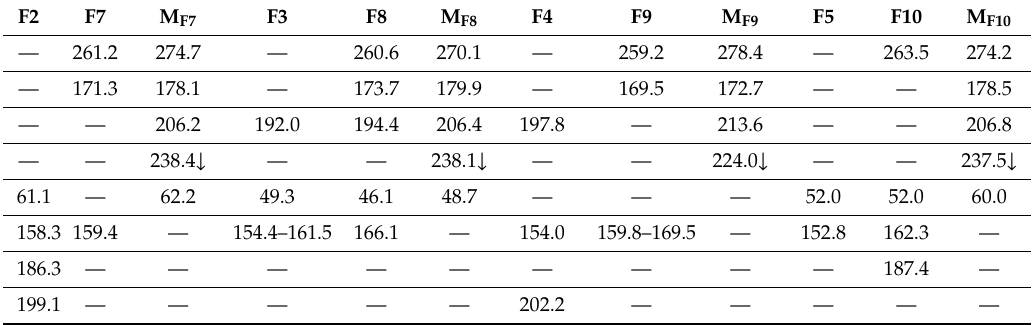
Table 5. The obtained DSC maxima of formulations F2–F5 and F7–F10 doped with synthetic polymer, and respective physical mixtures (M F7 –M F10 ), abbreviation described in the